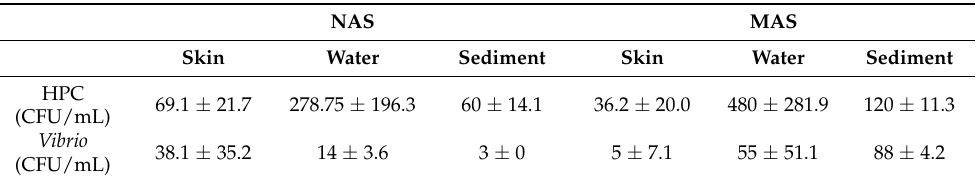
Table 3. Microbiological analysis of heterotrophic bacteria (HPC) and Vibrio count from skin swabs of European seabass, seawater, and sediment from NAS and MAS farm. NAS MAS Skin Water Sediment Skin Water Sediment HPC 69.1 ± 21.7 278.75 ± 196.3 60 ± 14.1 36.2 ± 20.0 480 ± 281.9 120 ± 11.3 (CFU/mL) Vibrio 38.1 ± 35.2 14 ± 3.6 3 ± 0 5 ± 7.1 55 ± 51.1 88 ± 4.2 (CFU/mL)